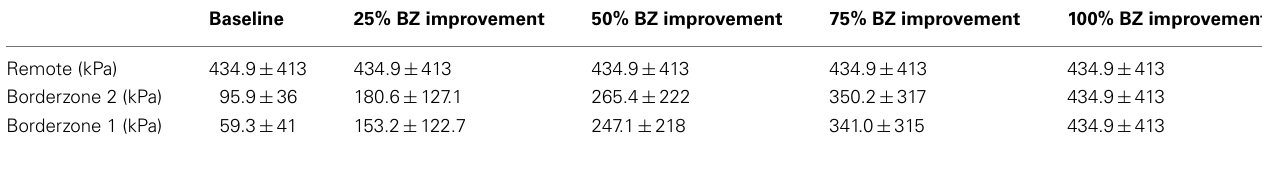
Table 1 | T max values used for the baseline case and the borderzone contractility enhancement